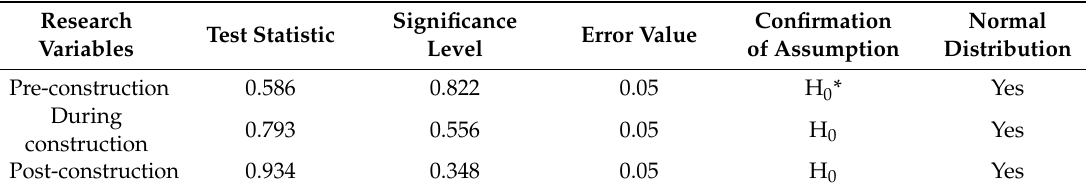
Table 3. The Kolmogorov–Smirnov test results.